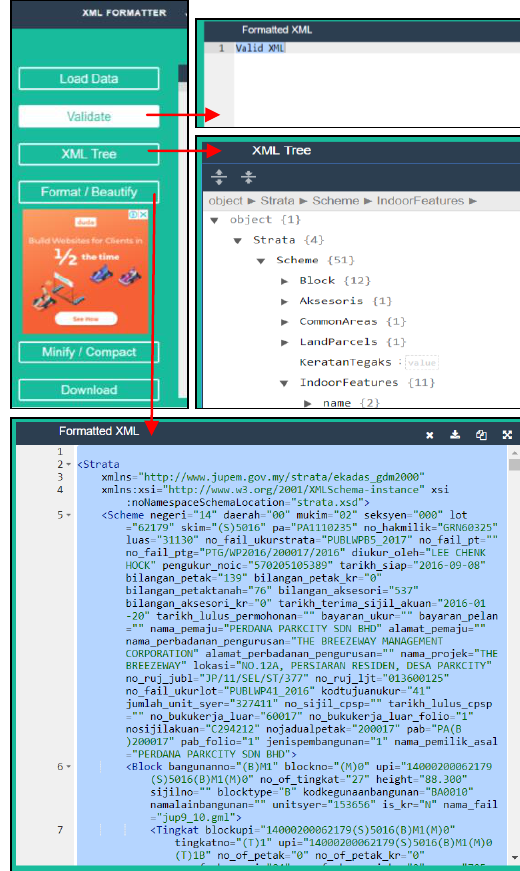
Figure 11. Integrated